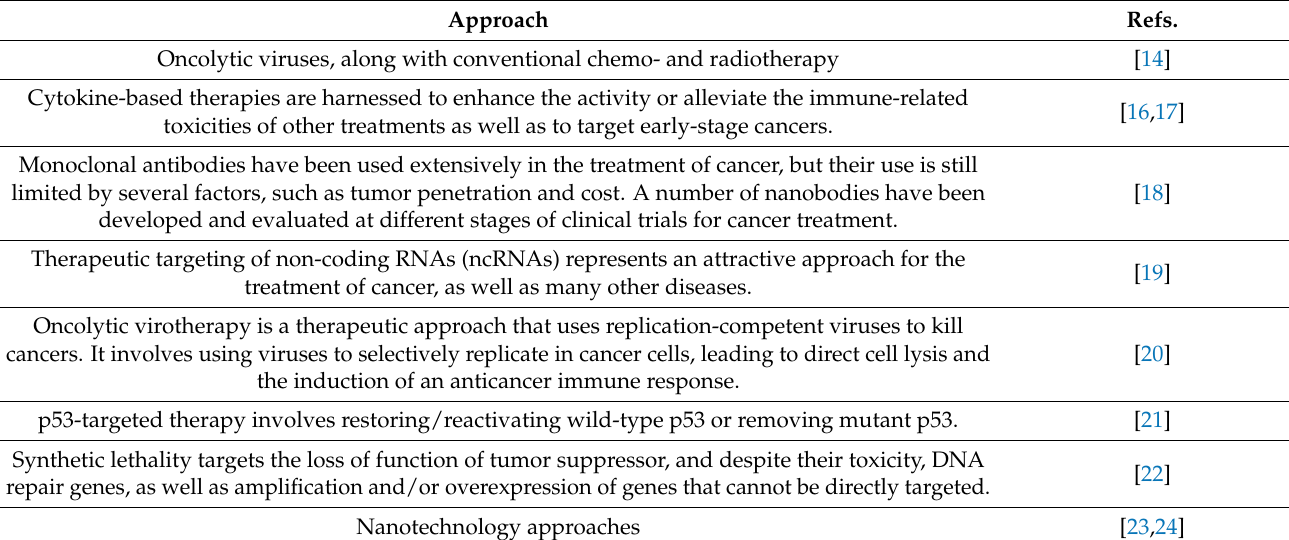
Table 1. Different approaches to the treatment of cancer. Approach